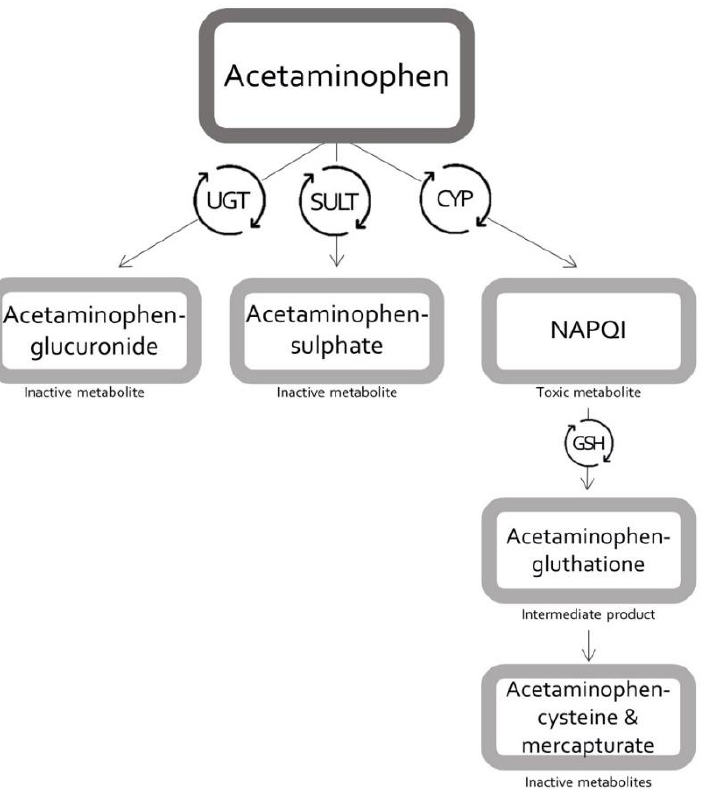
Figure 1. Schematic flow of acetaminophen metabolism. CYP = cytochrome P450; GSH = glutathione; NAPQI = N -acetyl- p -benzoquinone imine; SULT = sulfotransferase ; UGT = uridine 5′ -diphospho-glucuronosyl-transferase.